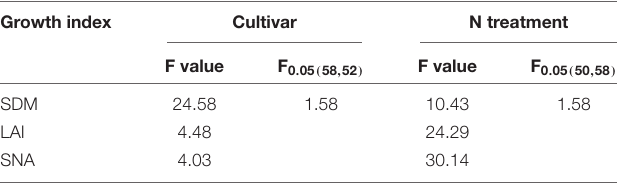
TABLE 5 | Analysis of variance of comparison of regression models between canopy cover and growth indices across different cultivars and nitrogen treatments.